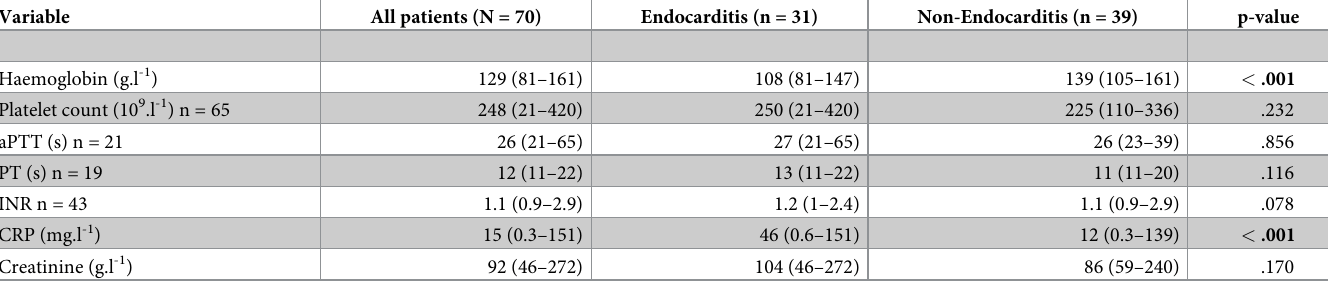
Table 2. Preoperative laboratory values in patients with and without infective